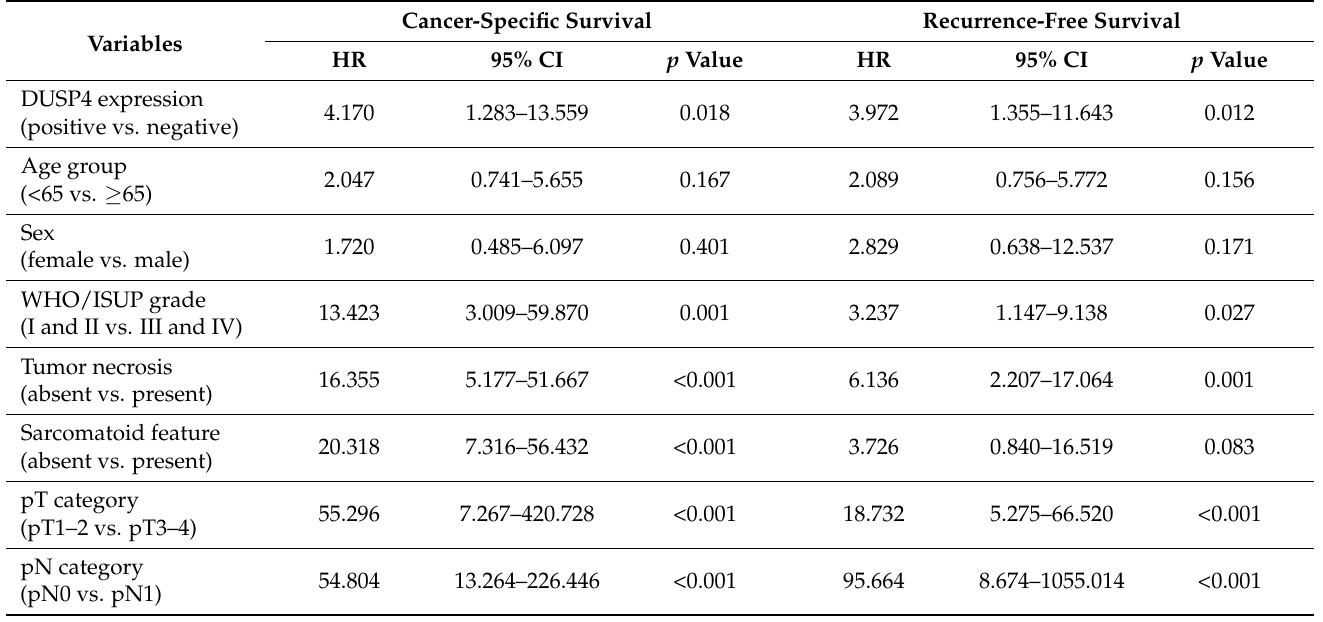
Table 4. The univariate Cox regression analyses for cancer-specific and recurrence-free survival in